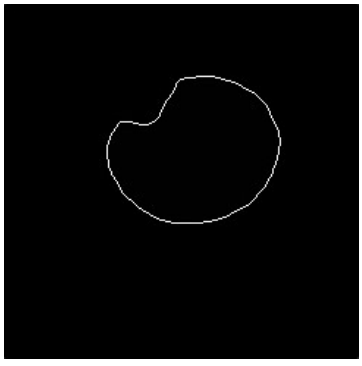
Figure 35. Maximum area contour.